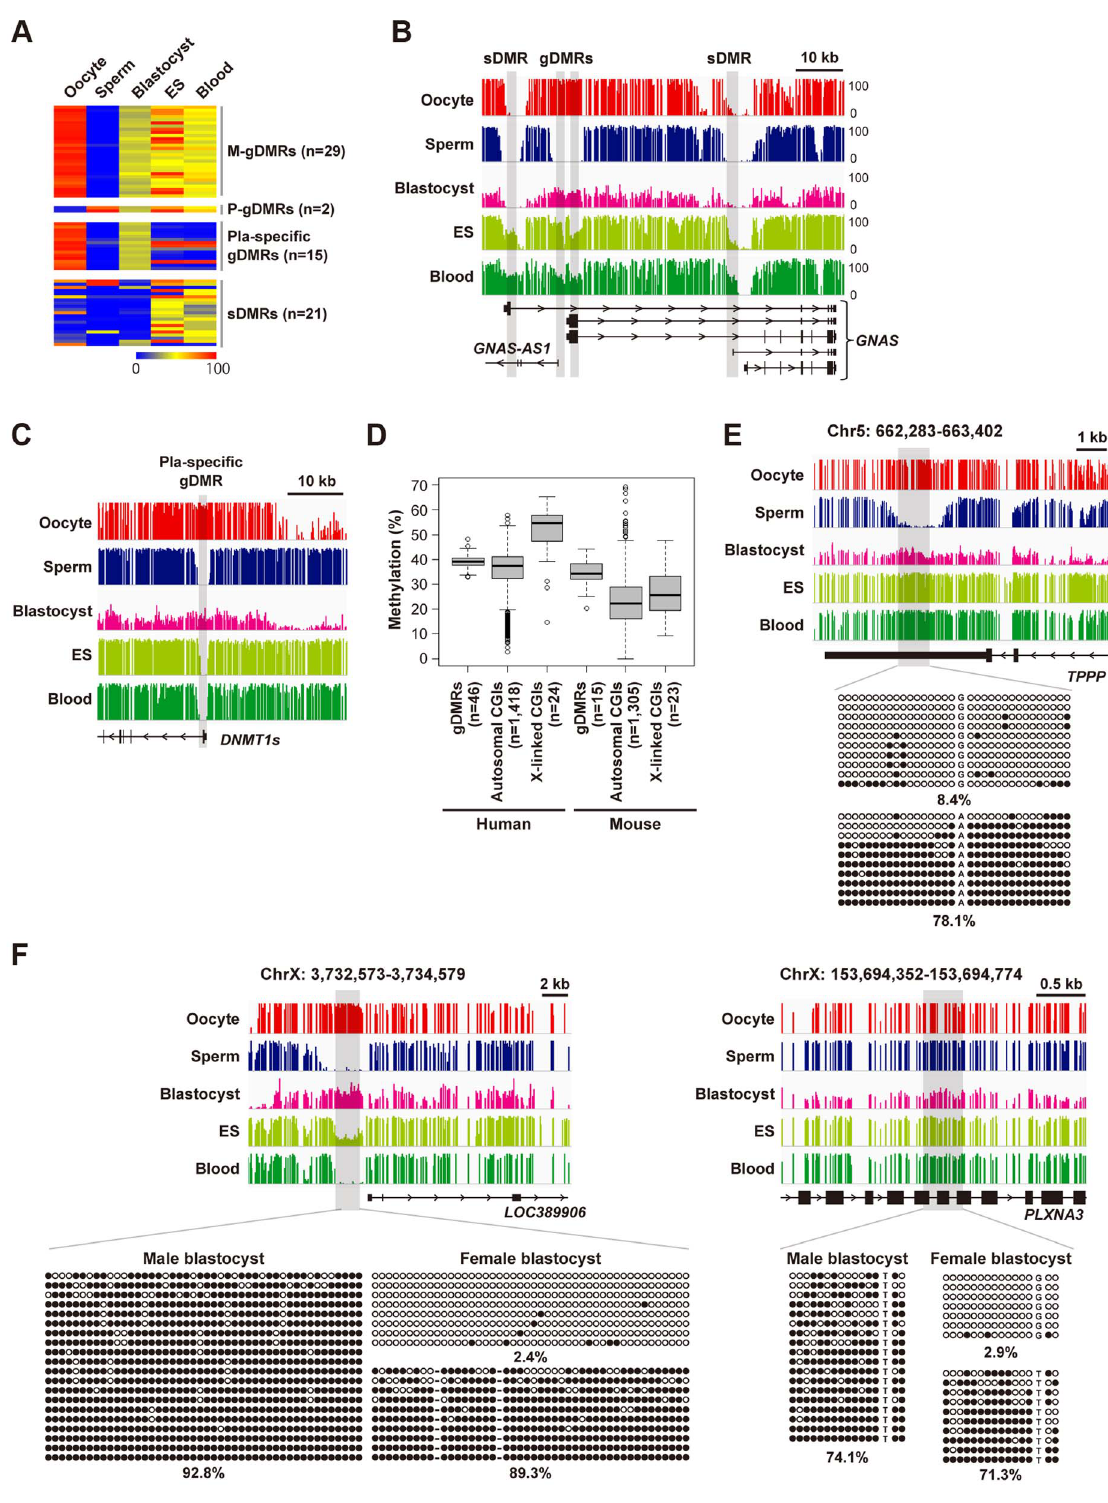
Fig. 2. Establishment and maintenance of imprinted DMRs. A, A heatmap of mean methylation levels of imprinted DMRs. We classified the 67 known human imprinted DMRs [17], and found that 44 were maternal germline DMRs (M-gDMRs), 2 were paternal germline DMRs (P-gDMRs) and 21 were secondary DMRs (sDMRs). 15 M-gDMRs are reported to be maintained only in the placenta and shown as ‘‘Pla-specific gDMRs’’. gDMRs other than placenta-specific ones showed 35–65% methylation levels in blood cells but the intermediate methylation levels were not well maintained in ES cells (11/31 showed . 75% methylation). Methylation levels are color coded as indicated. The raw data are shown in S1 Table. B, Methylation patterns at the human GNAS locus. The vertical axis indicates the methylation level (%). In this locus, there were two gDMRs and two sDMRs. All DMRs overlap promoter regions. C, Methylation patterns at the human DNMT1 locus. The promoter region of the somatic isoform of DNMT1 ( DNMT1s ) is known to show maternal allele-specific methylation in the placenta [45]. The DNMT1 DMR was hypomethylated in both ES and blood cells, suggesting placenta-